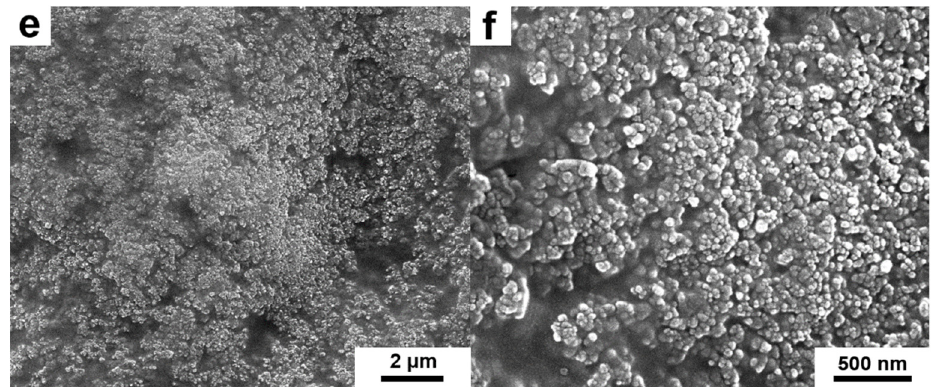
Figure 1. ( a ) Scheme; ( b ) photo; ( c and d ) low-magnification SEM image and corresponding EDS mapping of Ti element ( e and f ) high-magnification SEM images of the FPM. Photocatalytic activities of the FPM and BPM were evaluated by MO dye and